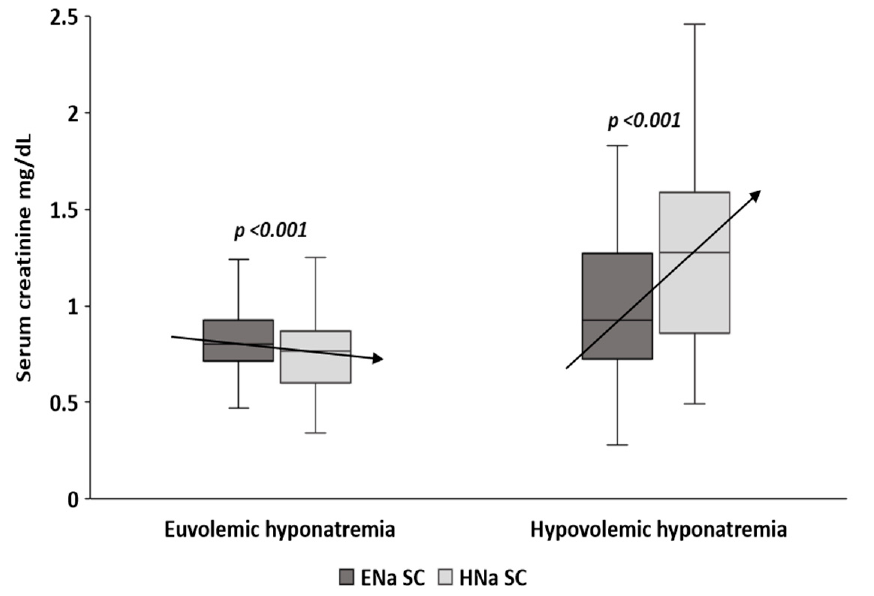
Figure 1. ∆ SC from eunatremia to hyponatremia according to volemic status during hyponatremia. The arrows indicate the trend of the change in SC during the hyponatremic episode when compared with eunatremia. ENa SC: serum creatinine coinciding with eunatremia. HNa SC: serum creatinine coinciding with hyponatremia.